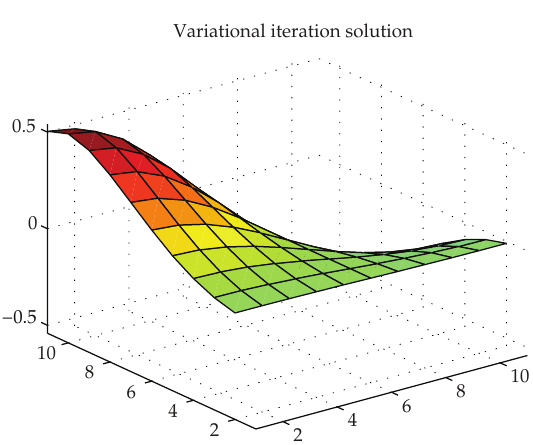
Figure 3: Variational iteration method for (cid:3) 3.10 (cid:4) .